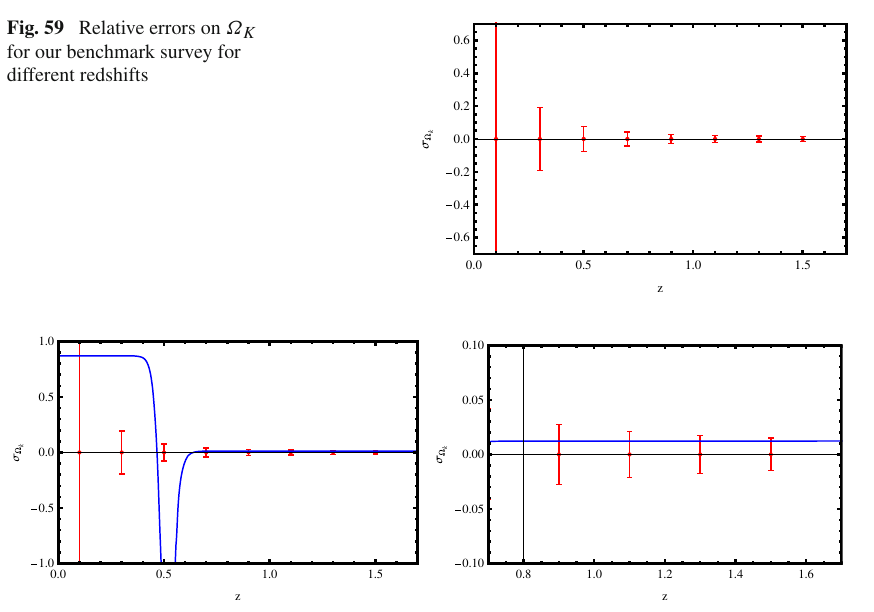
Fig. 59 Relative errors on Ω K for our benchmark survey for different redshifts